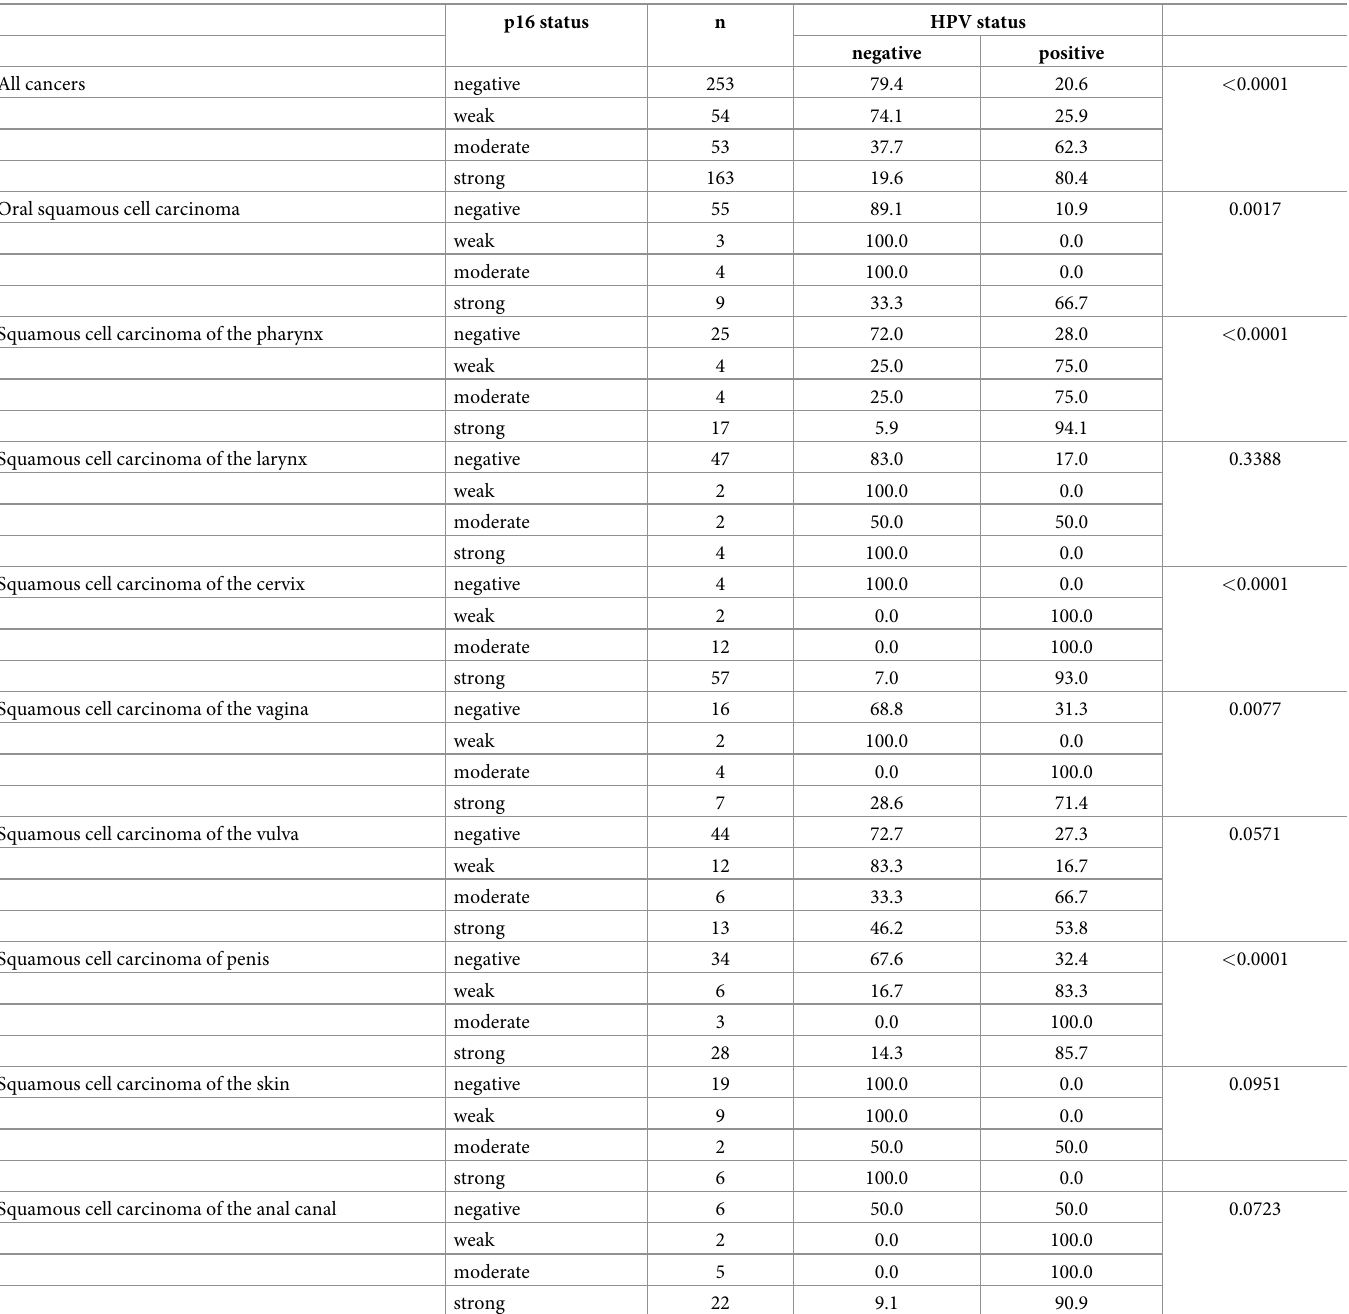
Table 3. Association between p16 immunostaining and HPV